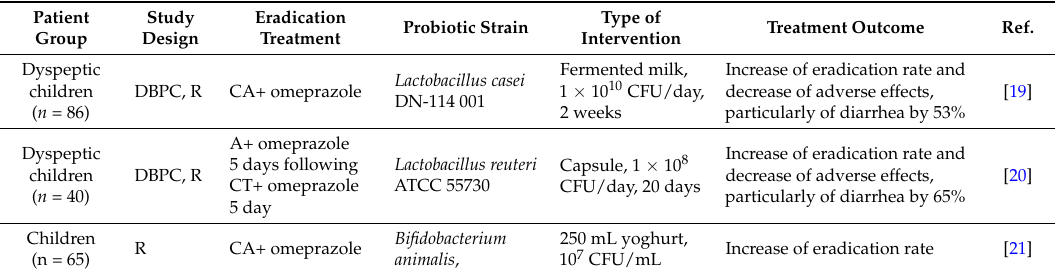
Table 1. Clinical trials using probiotics as dietary supplements during Helicobacter pylori ( H. pylori ) infection